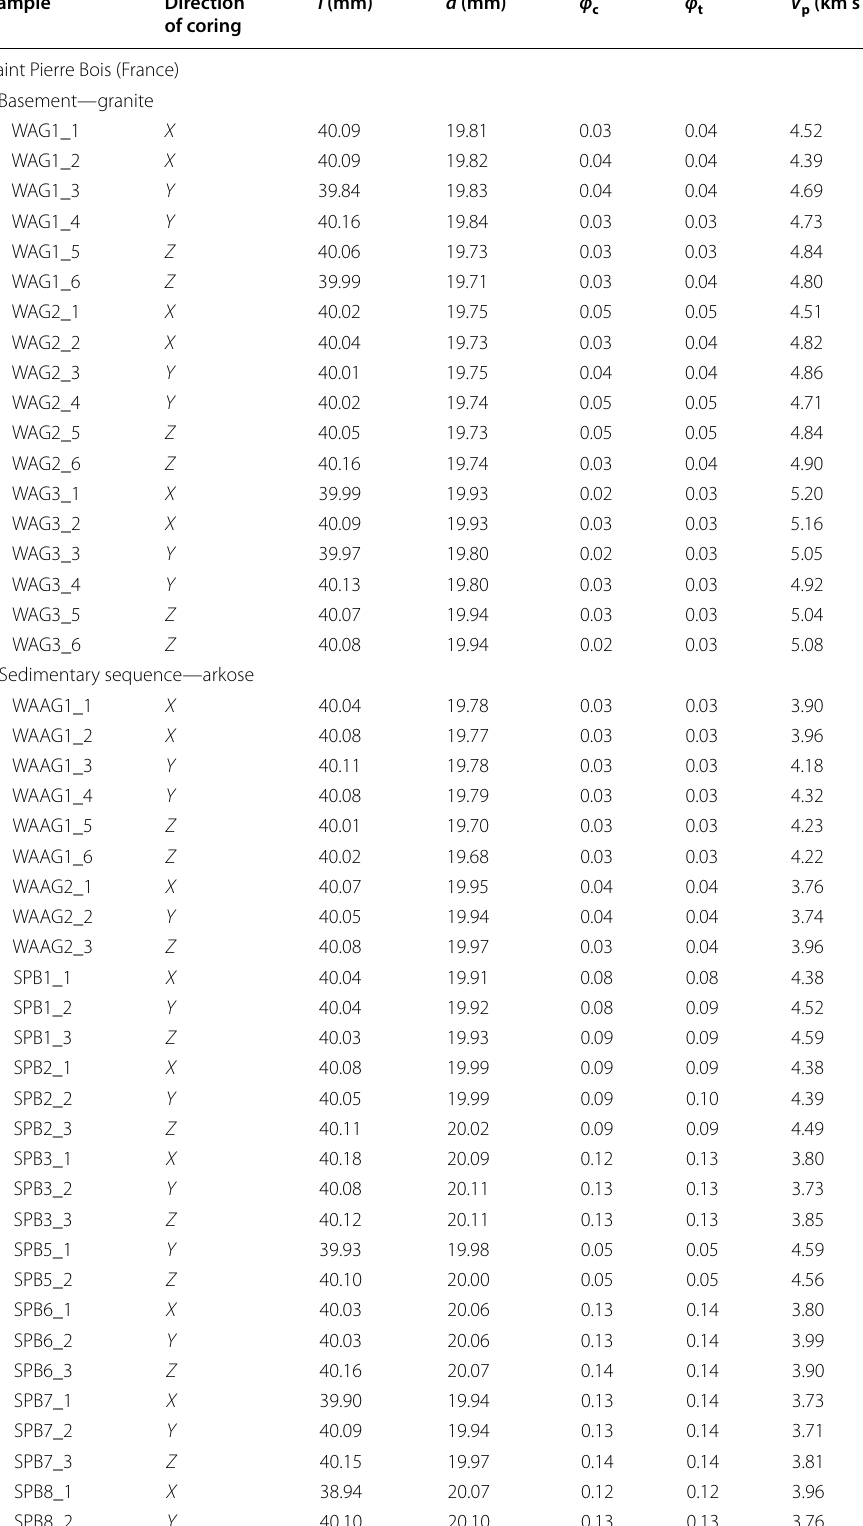
Table 2 Physical properties measured on the oriented core samples